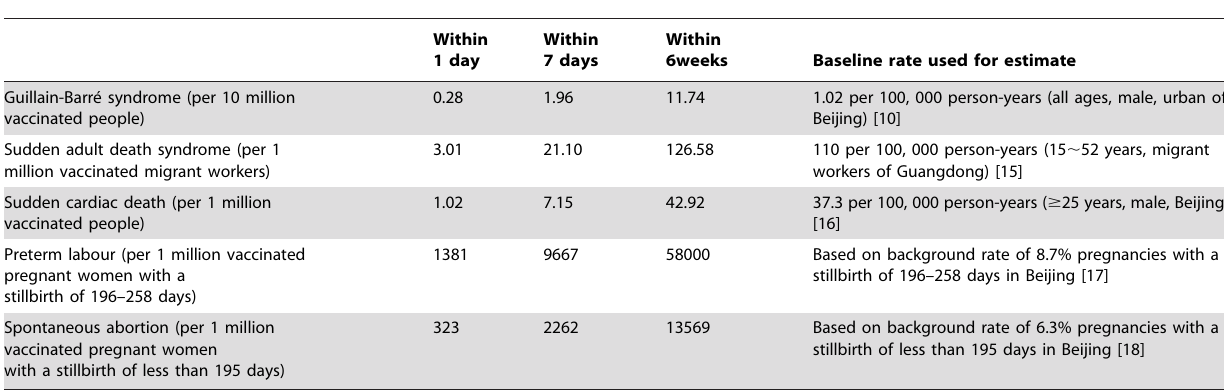
Table 4. The predicted numbers of coincident temporarily associated events after immunization.